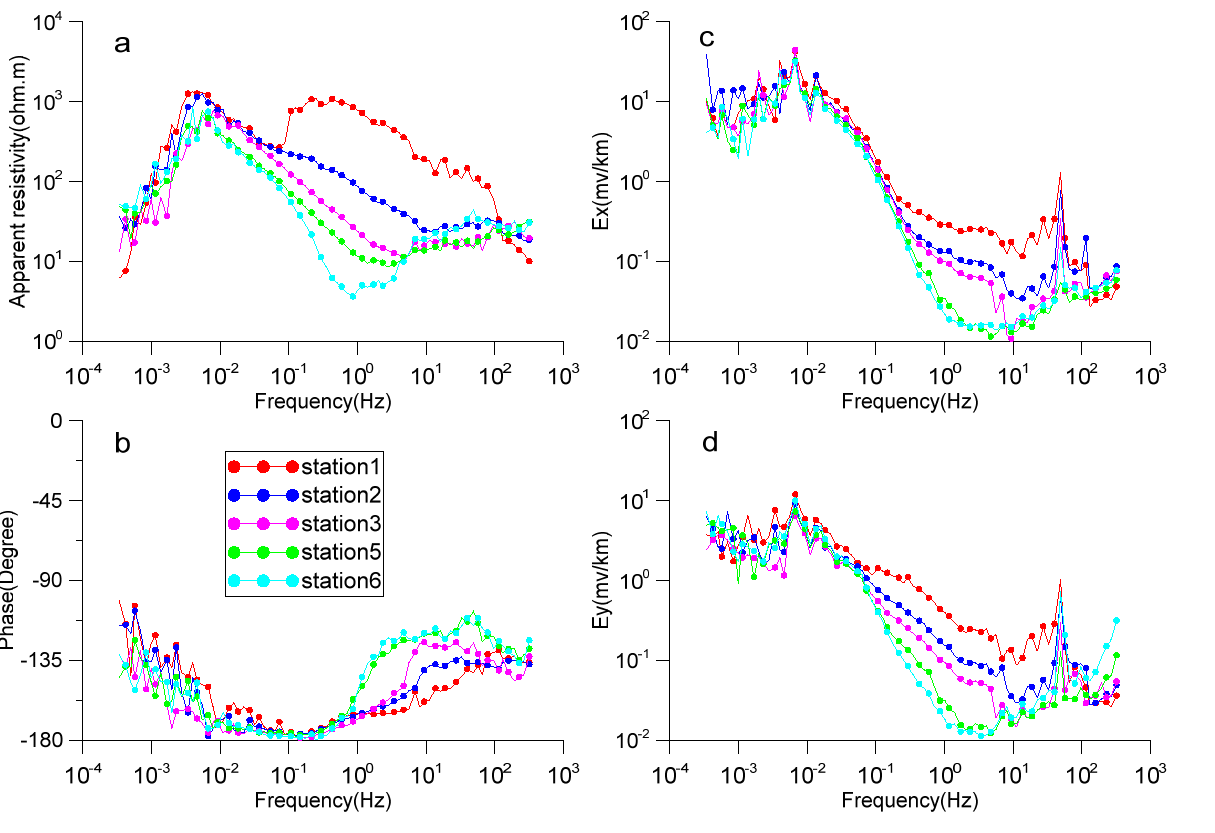
Figure 5. The frequency domain curves. ( a ) Apparent resistivity of ρ yx . ( b ) Impedance phase of φ yx . ( c ) Spectrum of Ex. ( d ) Spectrum of Ey.